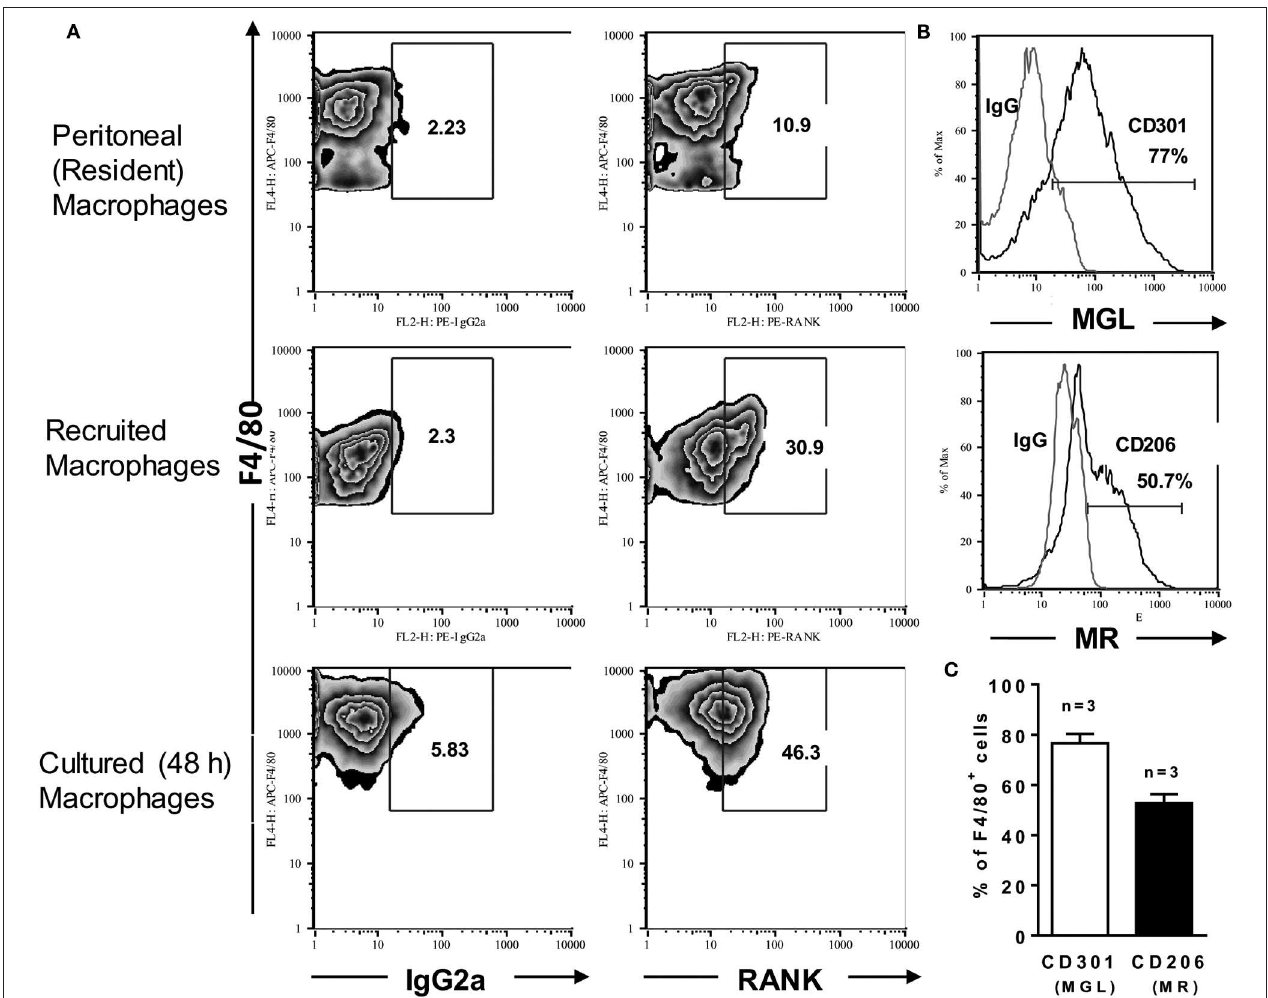
FIGURE 1 | Inflammatory macrophages express RANK and a M2-like phenotype. Peritoneal (resident) macrophages and thioglycolate-elicited (inflammatory) macrophages from B6 mice were analyzed for the expression of RANK or for the M2 hallmarks CD301 (MGL) and CD206 (MR). (A) Peritoneal cells were stained with anti-F4/80 and anti-RANK or control IgG2a. Where indicated, inflammatory macrophages were cultured in medium only during 48h before staining. (B,C) F4/80 + inflammatory macrophages were also stained with anti-CD301 or control IgG2b and anti-CD206 or control IgG2a, as indicated. In (C) , results are expressed as means and S.E.M. ( n = 3 mice). Data are representative of 3 independent